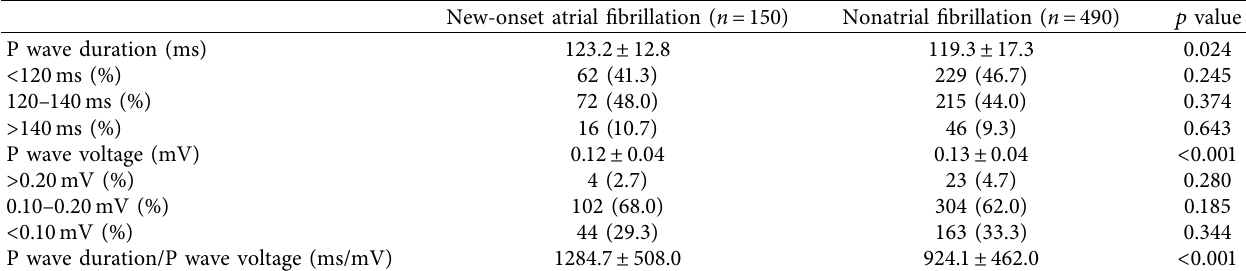
Table 6: Electrocardiographic findings of the study population.